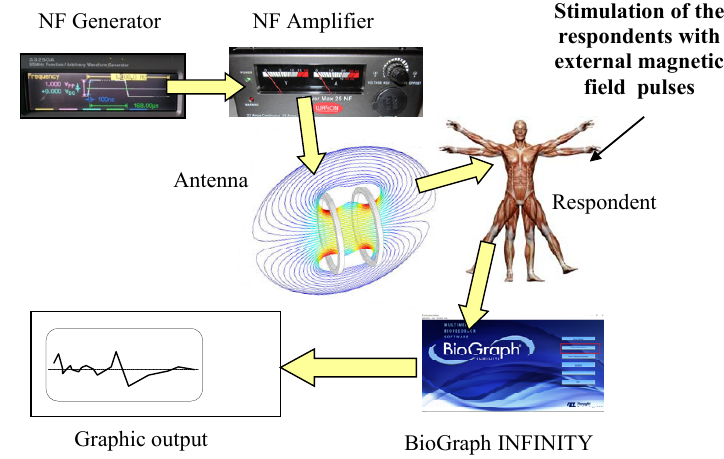
Figure 2. The measurement and simulation equipment.